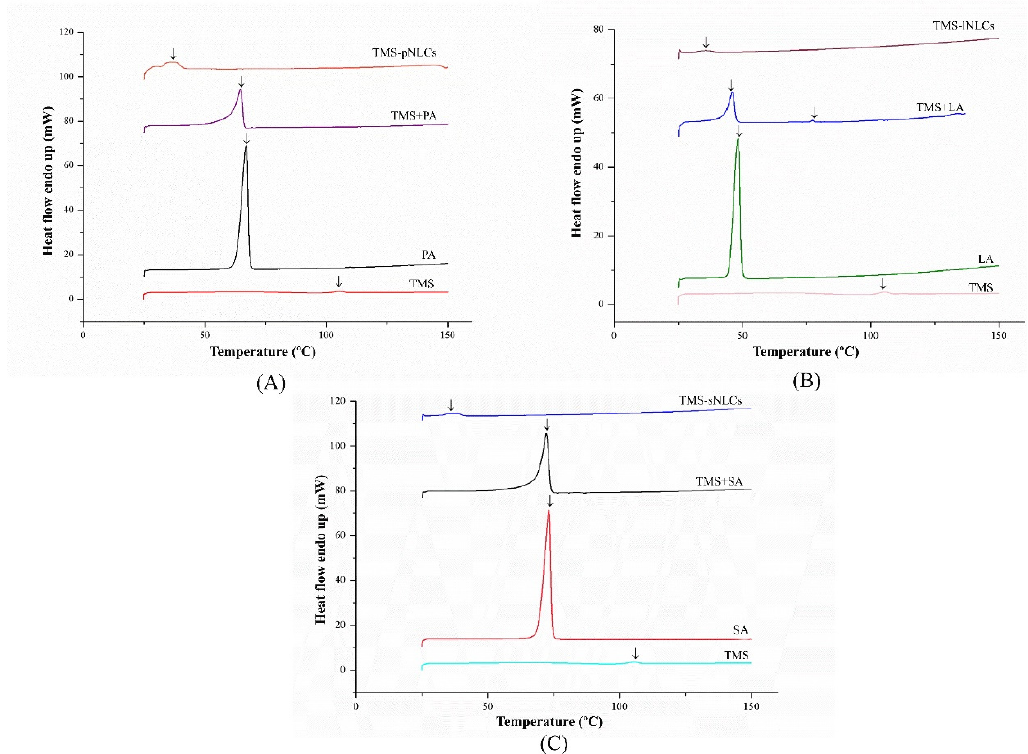
Figure 5. Di ff erential scanning calorimetry (DSC) curves of TMS-pNLCs ( A ), TMS-lNLCs ( B ), and TMS-sNLCs ( C Figure 5. Differential scanning calorimetry (DSC) curves of TMS ‐ pNLCs ( A ), TMS ‐ lNLCs ( B ), and TMS ‐ sNLCs ( C ).